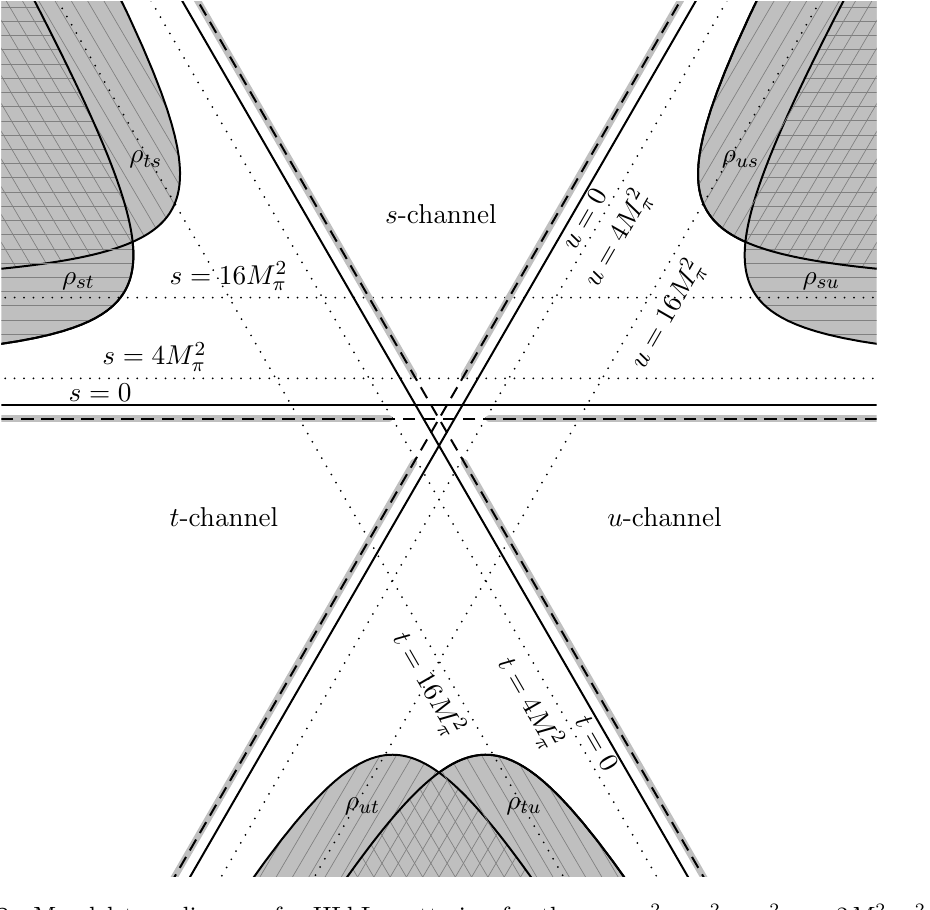
= q 2 = q 2 = 2 M 2 , q 2 = 0 (cid:25) 1 2 3 4 (cid:0)